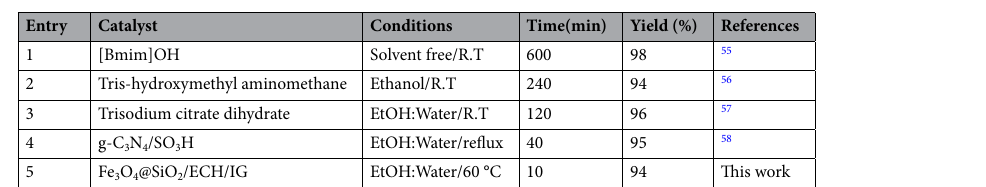
Table 2. Comparison of the present catalyst for the synthesis of spirooxindole derivatives with reported